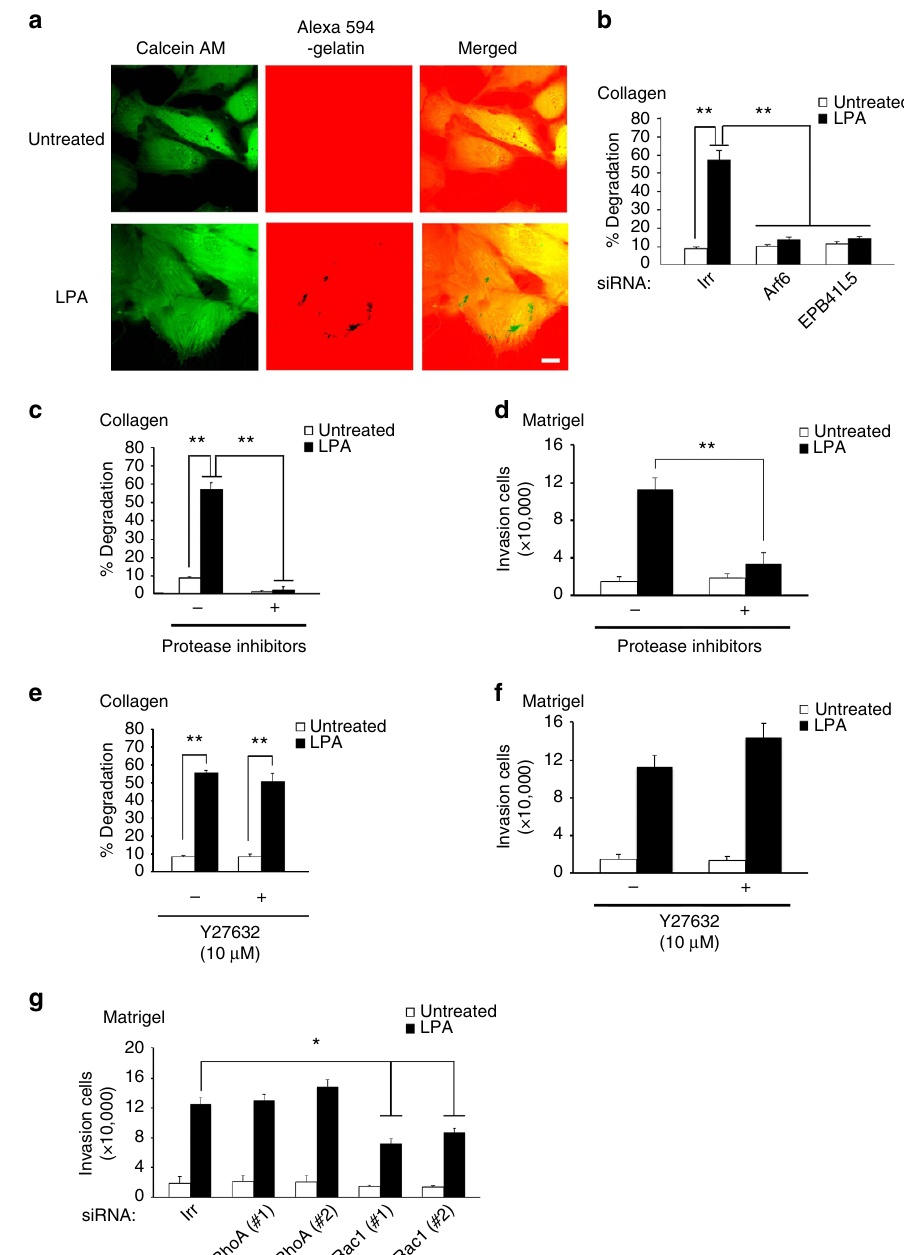
Figure 2 | Properties of LPA-induced invasion of 786-O cells. ( a ) Invadopodia formation on LPA stimulation. Cells were visualized using calcein AM, and areas of degradation of cross-linked Alexa 594-labelled collagen gels were shown as colourless areas (black dots in the middle panel). Scale bar, 10 m m. ( b ) Involvement of Arf6 and EPB41L5 in invadopodia formation. Cells were pretreated with siRNAs for Arf6 , EPB41L5 or an irrelevant sequence (Irr), before being subjected to the invadopodia formation assay with or without LPA. ( c – f ) Protease inhibitors ( c , d ), but not Y27632 ( e , f ), block LPA-induced matrix degradation ( c , e ) and Matrigel invasion ( d , f ). Inhibitors were applied to the cells 6h before the experiments and were present during the experiments. ( g ) RhoA, but not Rac1, is dispensable for LPA-induced invasion. Cells were pretreated with siRNAs for RhoA , Rac1 or Irr, before being subjected to the Matrigel invasion assay with or without LPA. ( b , c , e ) Percentages of cells exhibiting invadopodia are shown as % degradation. ( b and c – g ) Error bars represent the mean ± s.e.m., n ¼ 3. * P o 0.05, ** P o 0.01. Statistical analyses were performed using analysis of